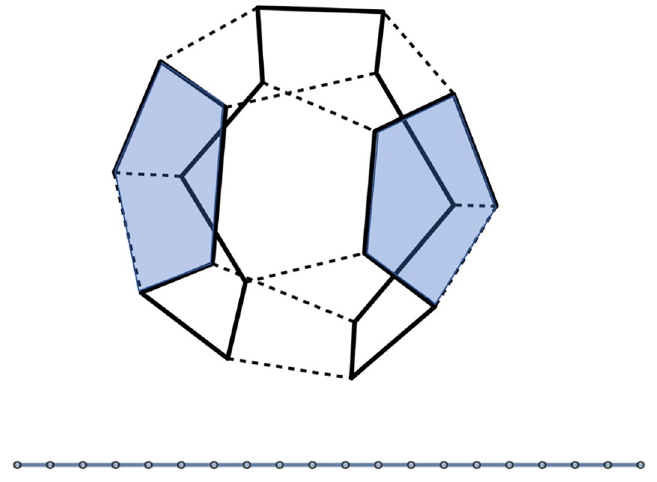
Fig 2. Example of a spanning tree in the form of a Hamiltonian path of a dodecahedron. In blue are shown two pentamers that can be placed on the dodecahedron such that their edges make the maximum of four contacts with links of the spanning